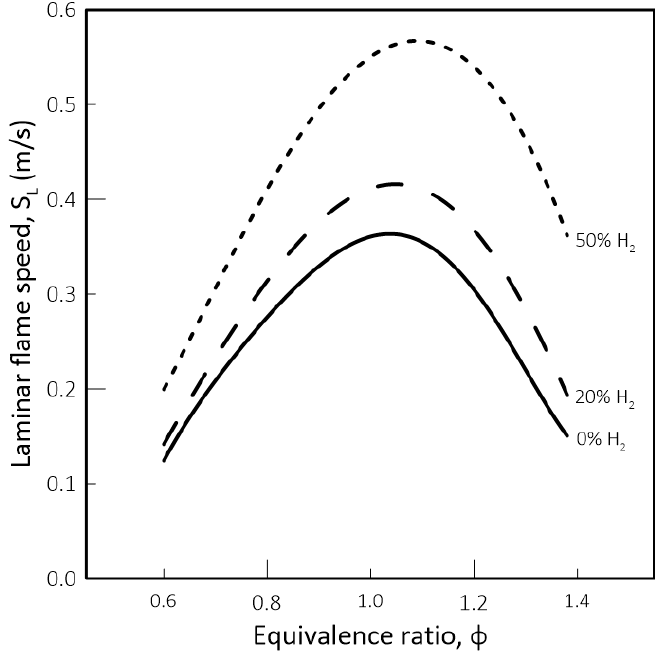
Figure 7. Laminar flame speed of CH /air flames at three levels of hydrogen blending by volume: 4 0%, 20% and 50%. Conditions were set at T u = 298K, p = 1atm and 0.6 < φ < 1.4.